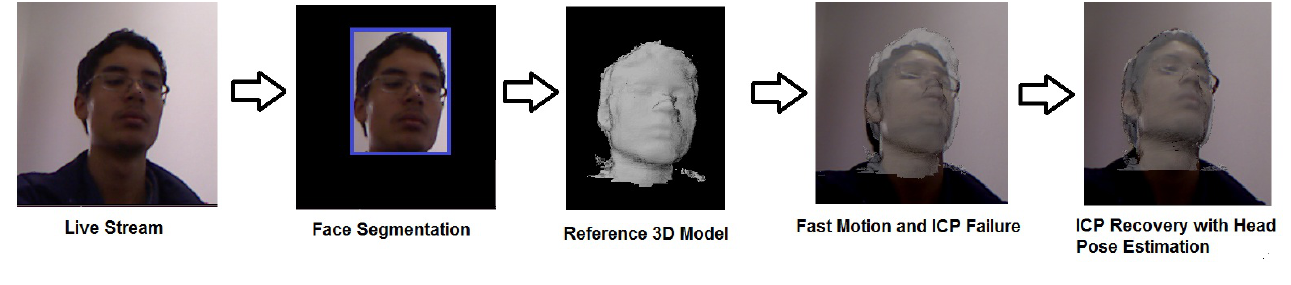
Fig. 1. Overview of the online processing pipeline. A) RGB-D live stream. B) A face detector is used to locate and segment the face from the rest of the scene. C) Reference 3D model is reconstructed with KinectFusion. D) In a MAR system, the user rotated his face fast and the ICP failed. E) The head pose estimation is used to give an initial guess to the ICP and the fast motion is compensated.